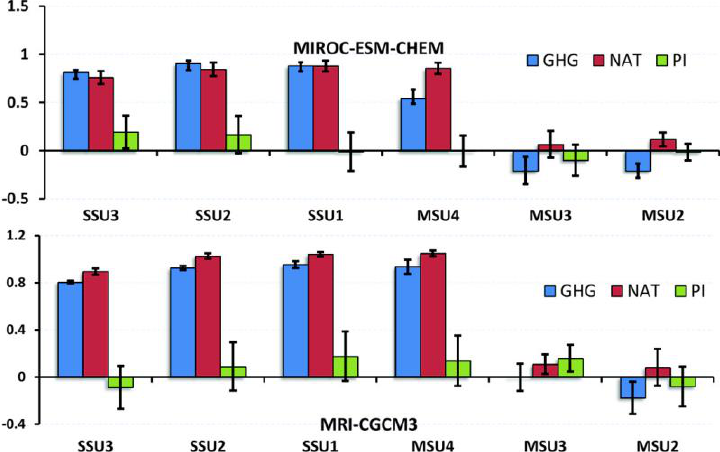
Figure 8. Same as Figure 7 except for MSU4, MSU3, SSU2, and SSU1.